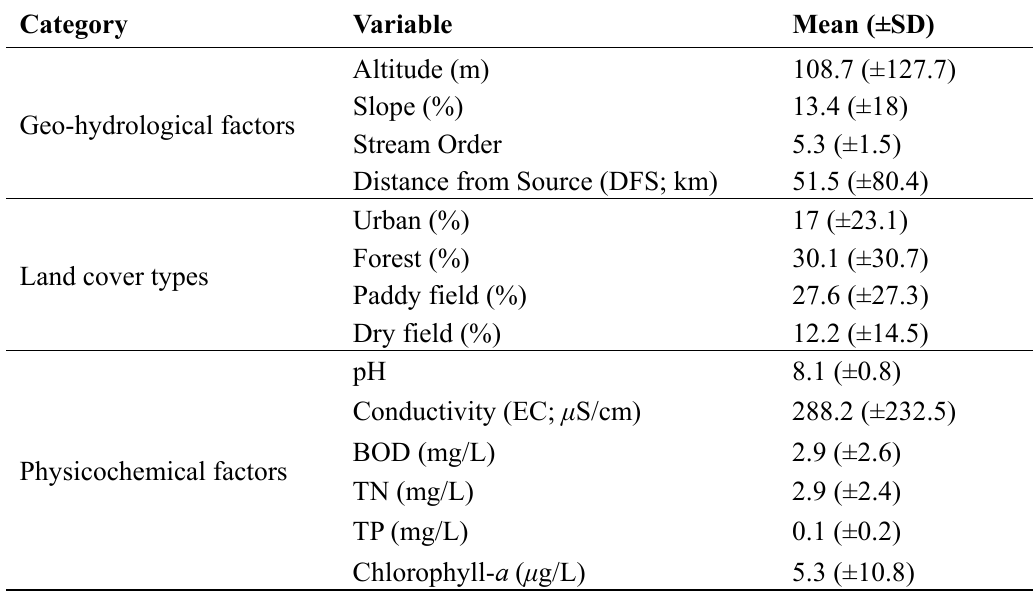
Table 1. Mean and standard deviation of 14 environmental variables in 691 sampling